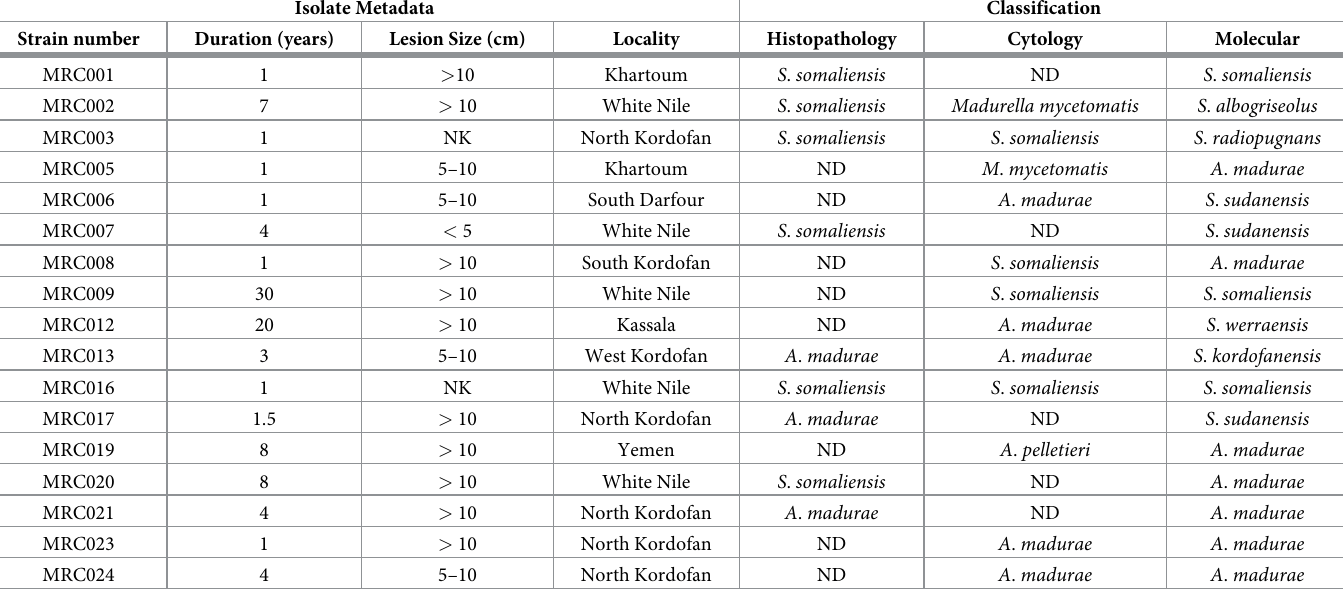
Table 4. Initial clinical classification of isolates compared to the molecular taxonomic